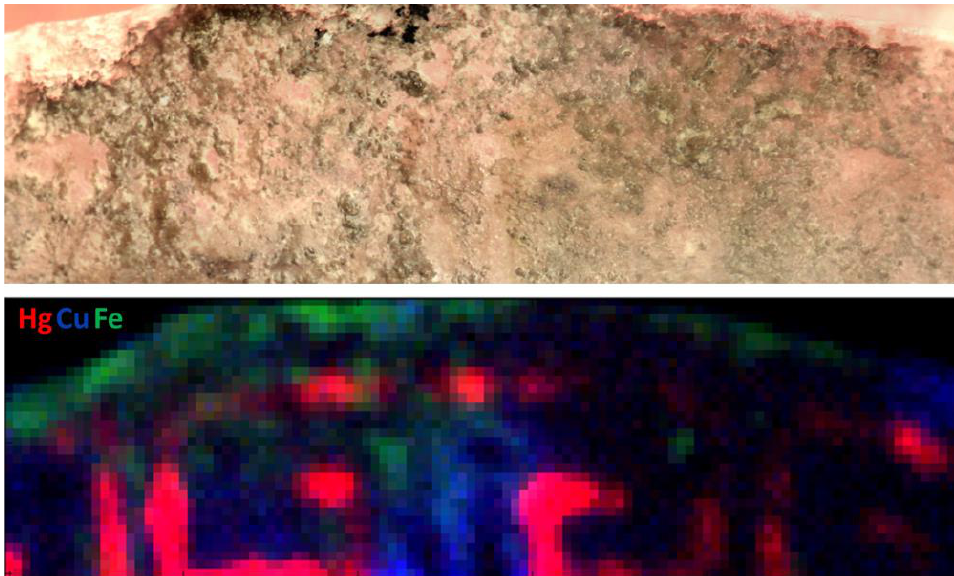
Figure 5. Composite elemental maps of Cu, Hg, and Fe resulting from scanning the diadem (area B of Figure 4), whose decoration hides underneath a thick accretion (top image). Two areas of the proper right wing (Figure 4, areas A and E) were also scanned with sXRF to reconstruct the design and color scheme of the feathers, even where minimal residues of the original pigments were observed. The detection of Hg indicates that cinnabar was used for the red feathers, while Cu indicates the use of two Cu-containing pigments for the blue feathers (Figure 6).